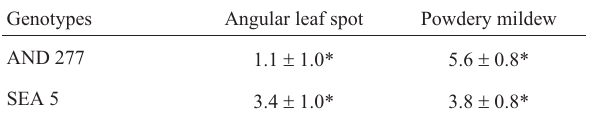
Table 2 - Estimates of means, standard deviations and broad sense herita- bilities for angular leaf spot and powdery mildew resistances.